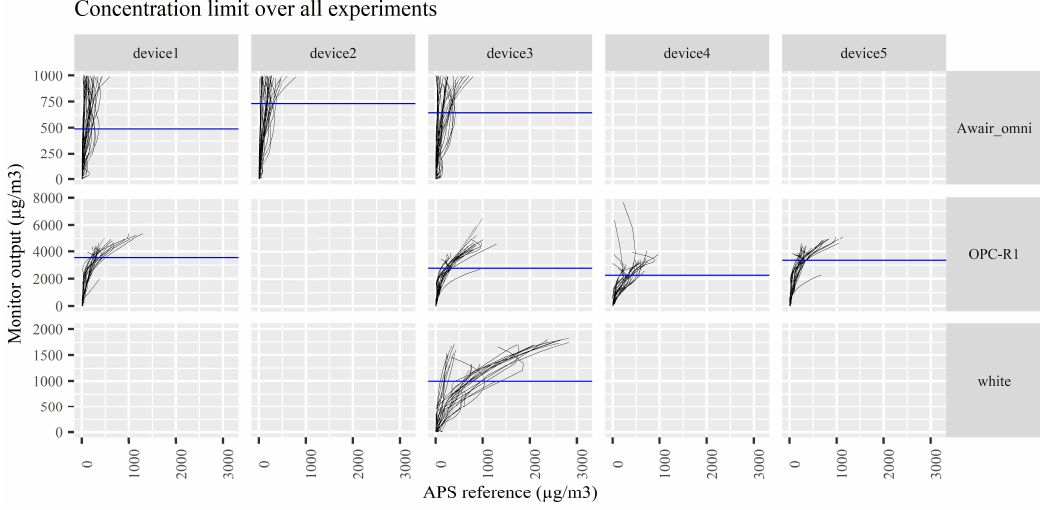
Figure 2. Concentration limit finding for the relevant units (negative correlation in ≥ 10% of experiments) of Awair omni, OPC-R1 and white prototype monitors. Correlation plots of the low-cost monitor PM 2.5 compared to the APS reference PM 2.5 fractions. Each experiment forms one line. Negative correlations show as a half-circle shape. The horizontal blue line depicts the calculated concentration limit, which is calculated as p10 of the individual concentration limits for each